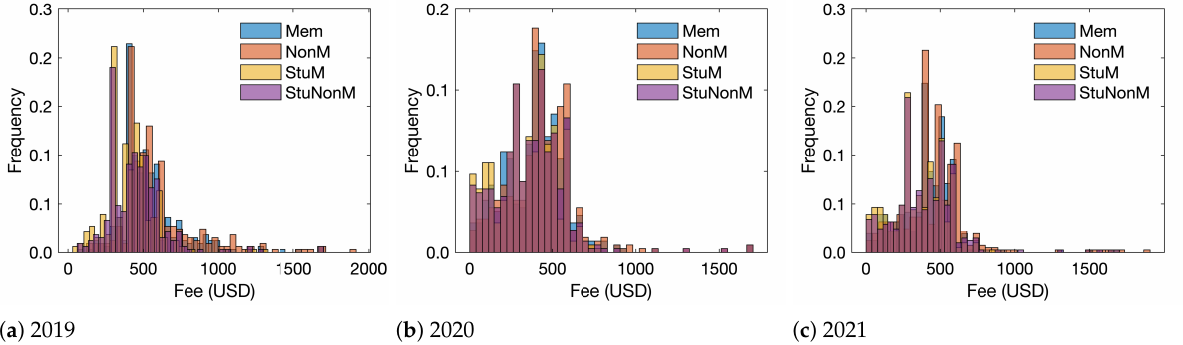
Figure A3. Histograms of the conference registration fees. The number of bins is set to be 45. ( a ) Histograms of the four types of registration fees for conferences held in 2019. ( b ) Histograms of the four types of registration fees for conferences held in 2020. ( c ) Histograms of the four types of registration fees for conferences held in